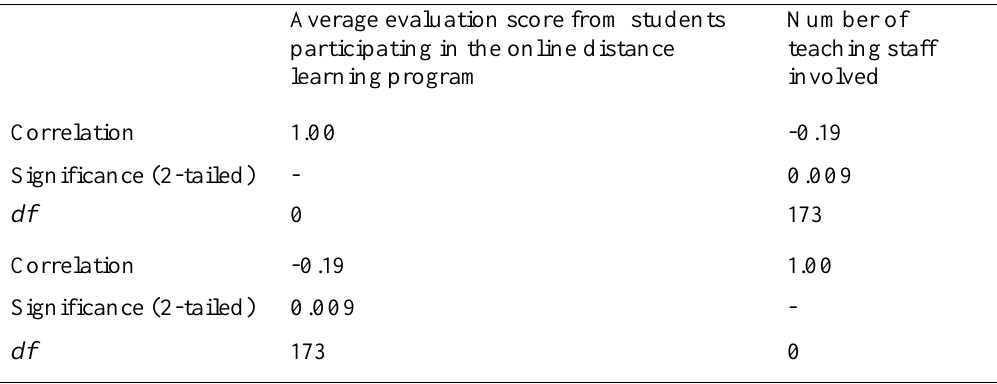
Correlation between Mean Evaluation Scores for Specific Online Courses and the Number of Teaching Staff Involved in these